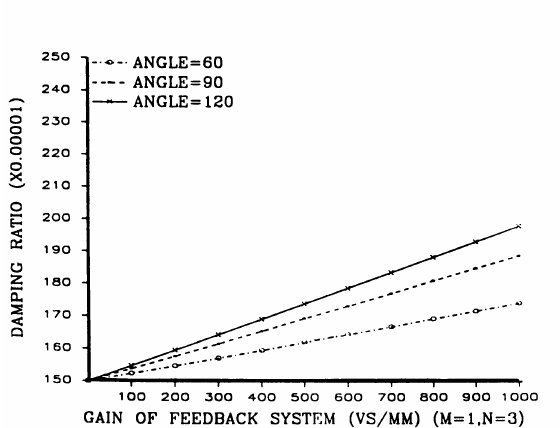
FIGURE 6 Damping control of the laminated shell, (1,3) mode.